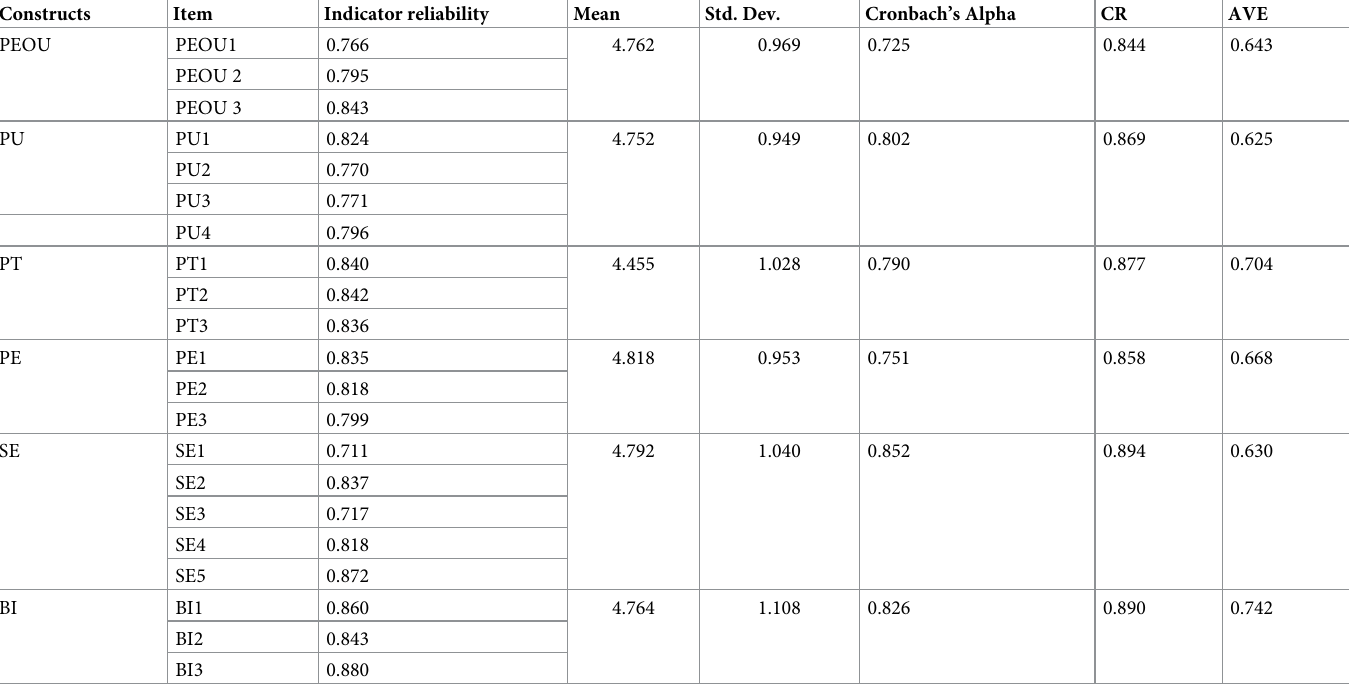
Table 2. Mean, standard deviation, reliability and validity of variables.